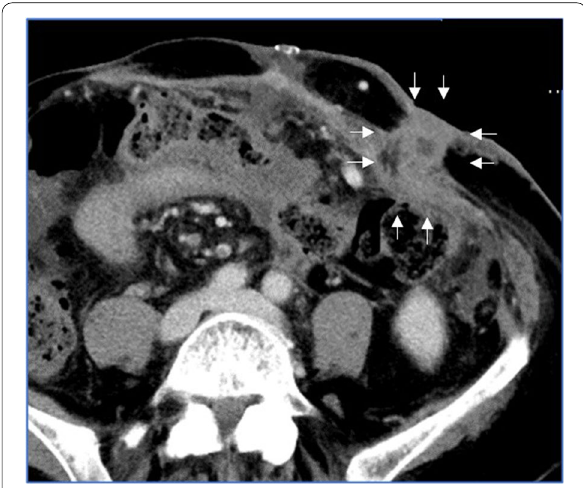
Fig. 4 Abdominal CT imaging 7 days after the hybrid surgery. The feeding veins were occluded and the ileal conduit stomal varices had